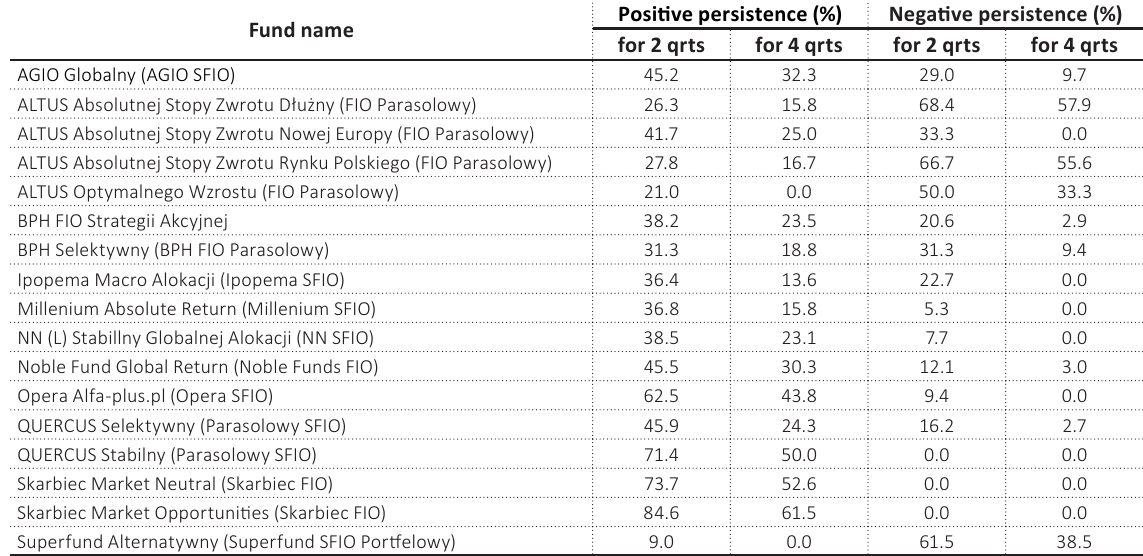
Table 1. Performance persistence of FIO and SFIO absolute return funds in